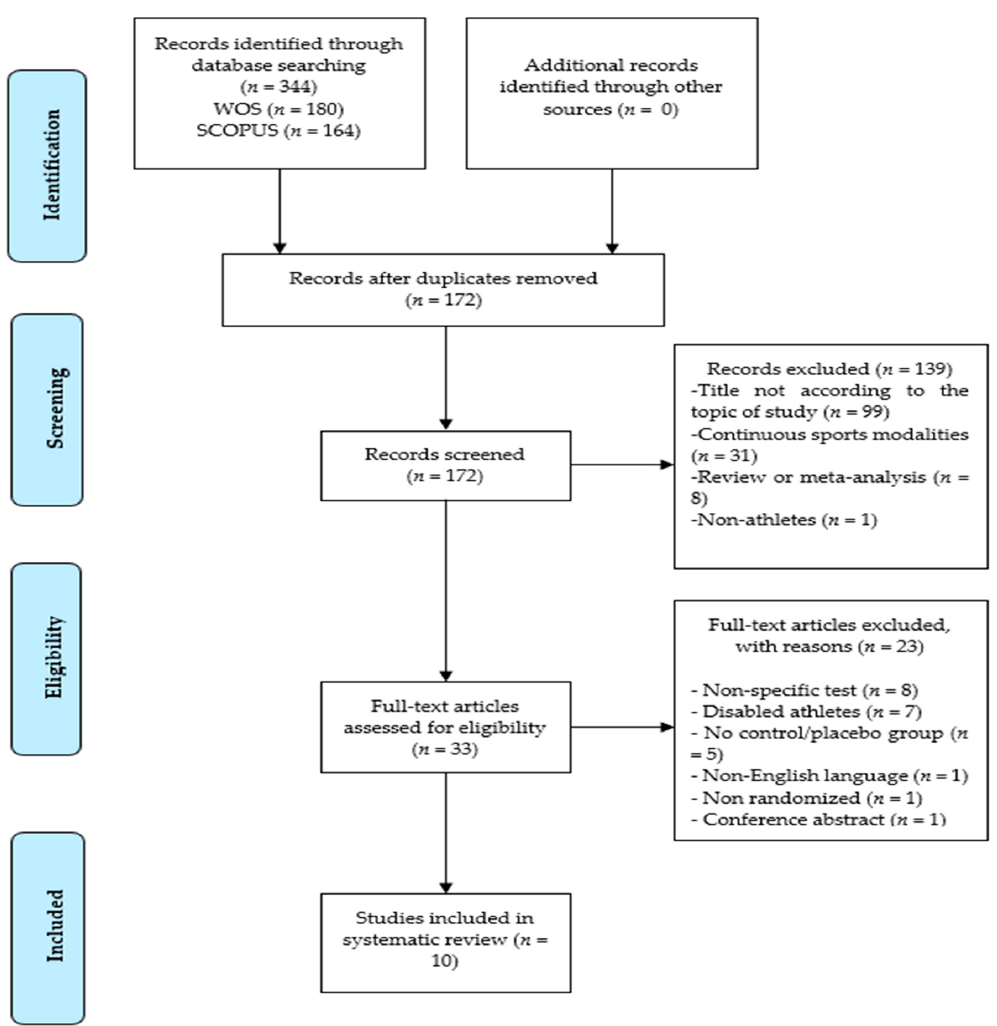
Figure 1. Preferred Reporting Elements for Systematic Reviews and Meta-Analyses (PRISMA) flow diagram.